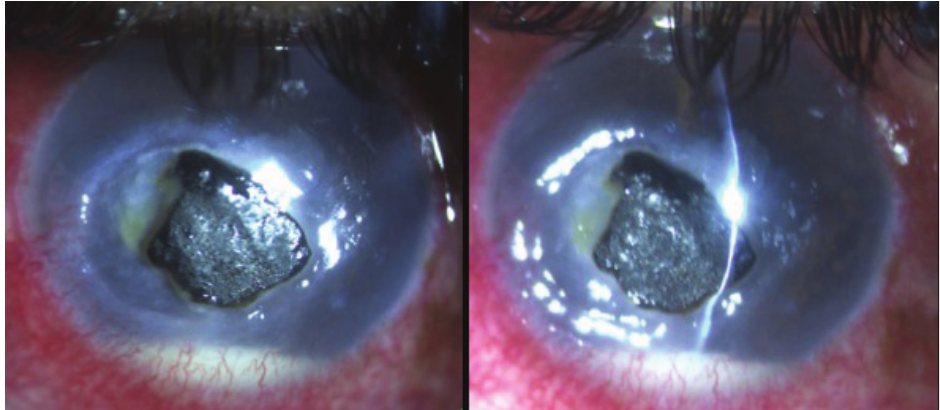
Figure 1. (a) A corneal ulcer measuring 6.5 × 5.5 mm, with a central pigmented plaque 4 × 4 mm with hypopyon. (b) Slit view showing area of corneal thinning.